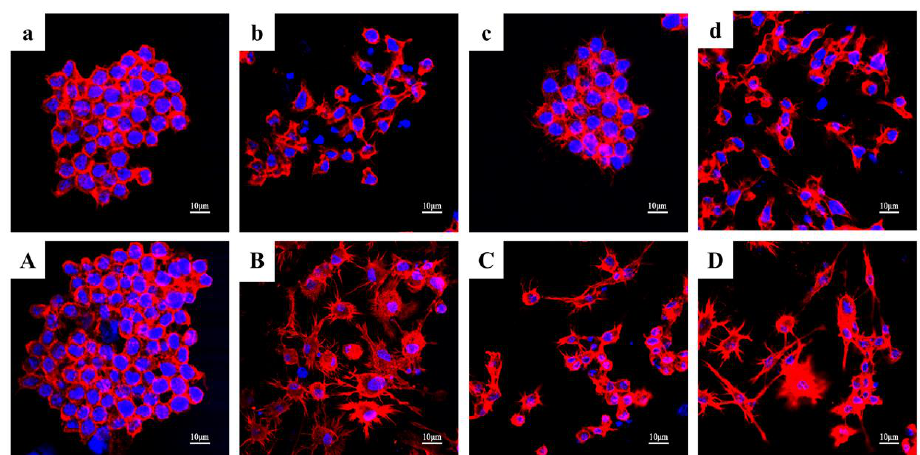
Figure 10. Changes in cell morphology under CLSM of RAW 264.7 cells cultured for day 1 and day 3 after different treatments. Note: lowercase letters represent images from day 1 and uppercase letters represent images from day 3. ( a , A ) BLANK control group. ( c , C ) KN-17 was added without LPS. ( b , B ) LPS treatment group. ( d , D ) KN-17 and LPS were added at the same time.